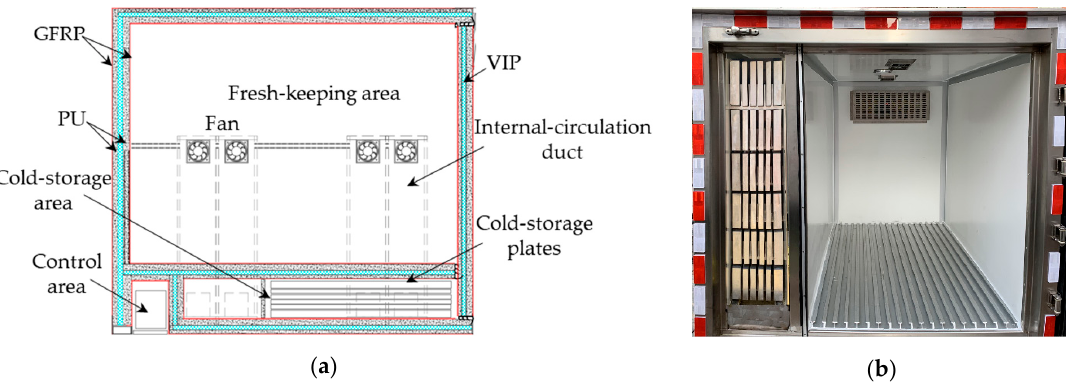
Figure 1. Structure of insulated temperature-controlled container (ITCC): ( a ) vertical view and ( b ) side elevation. Table 1. ITCC material property parameters. VIP, vacuum insulation board; PU, polyurethane; GFRP, glass-fiber-reinforced composite plastics.